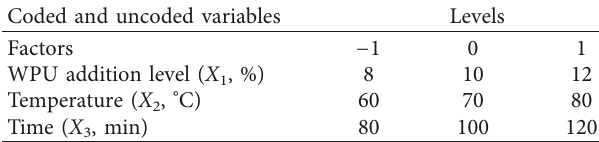
Table 1: Variables and levels used in RSM design. Table 2: Experimental scheme and results.